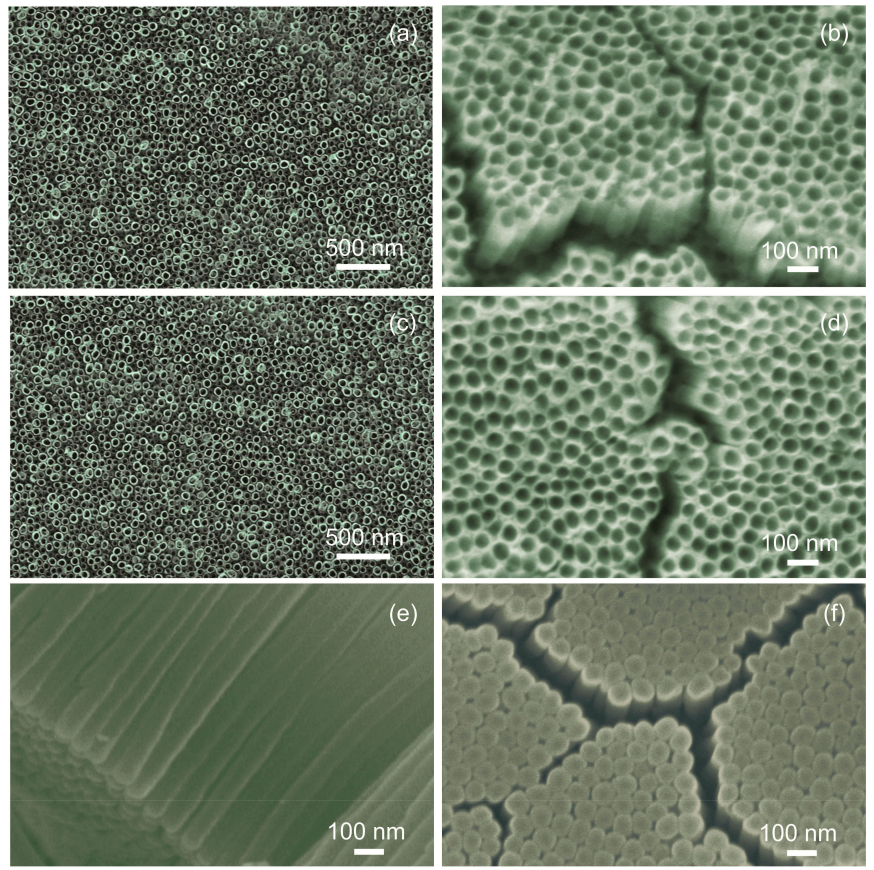
Figure 6. Scanning electron microscopy (SEM) micrographs of the obtained tubular samples: ( a ) and ( b ) the surface morphology of pure TNT arrays with the different magnifications; ( c , d ) the surface morphology of 12 wt % Nb-doped TNTs with the different magnifications; ( e ) the cross-sectional view of 12 wt % Nb-doped TNTs, and; ( f ) the bottom-view of 12 wt % Nb-doped TiO 2 tubular